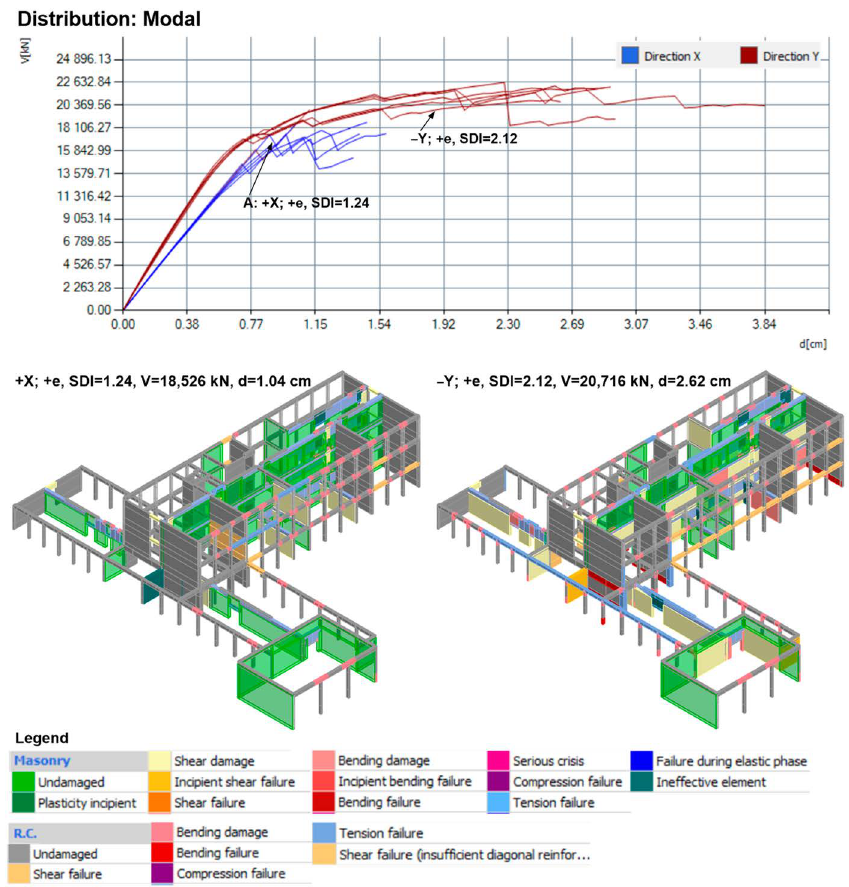
Figure 31. EFM results: pushover curves and corresponding damage mechanism of the retrofitted structure obtained using the modal load pa tt ern.